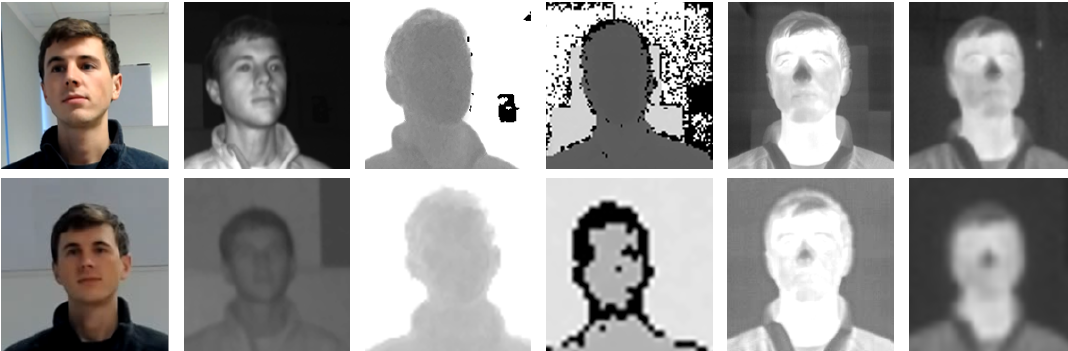
Figure 2. Images from the MultiSFace dataset. In the first row, sensors are placed near the subject (1 m), while in the second row sensors are placed far (2.5 m). Starting from the left: RGB and infrared images, high- and low-resolution depth maps, and high- and low-resolution thermal images. Section 3.3 reports further details. From the comparison, it is possible to evaluate how much the distance from the acquisition device and sensor resolution influences the collected